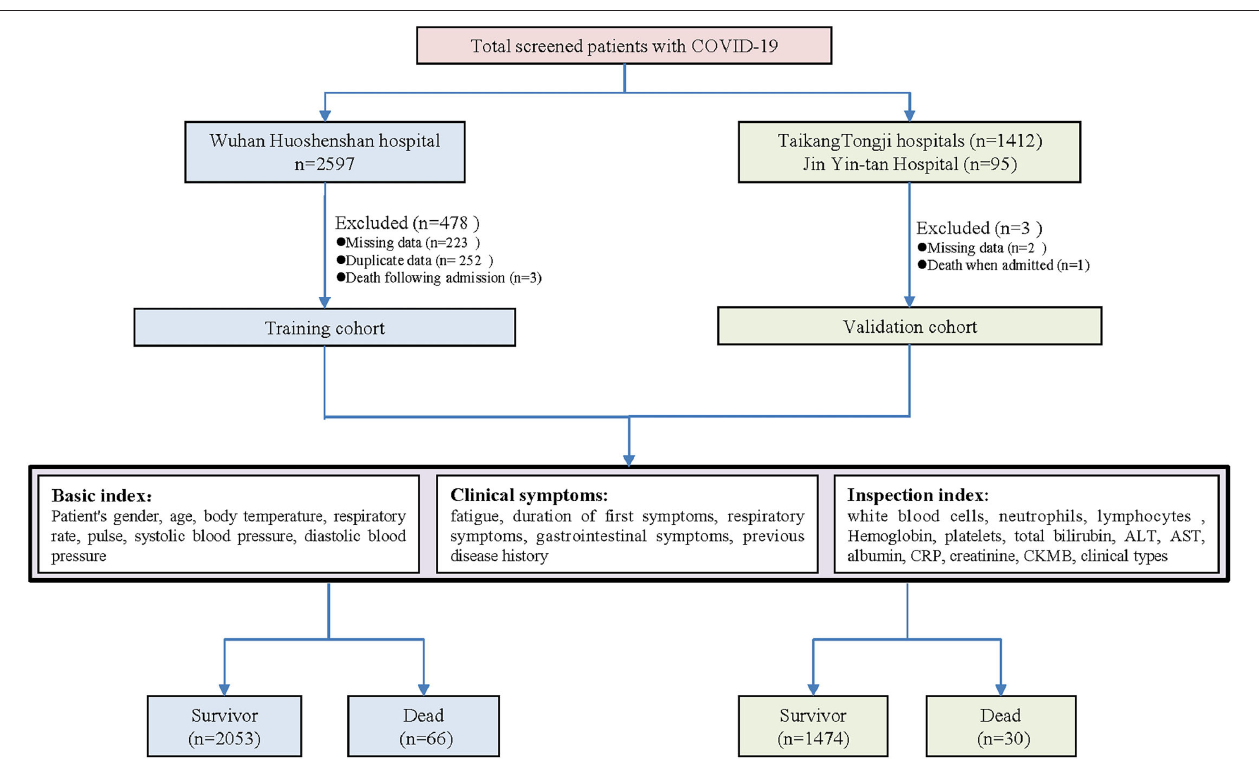
FIGURE 1 | Enrollment flowchart of the study population in the training and validation